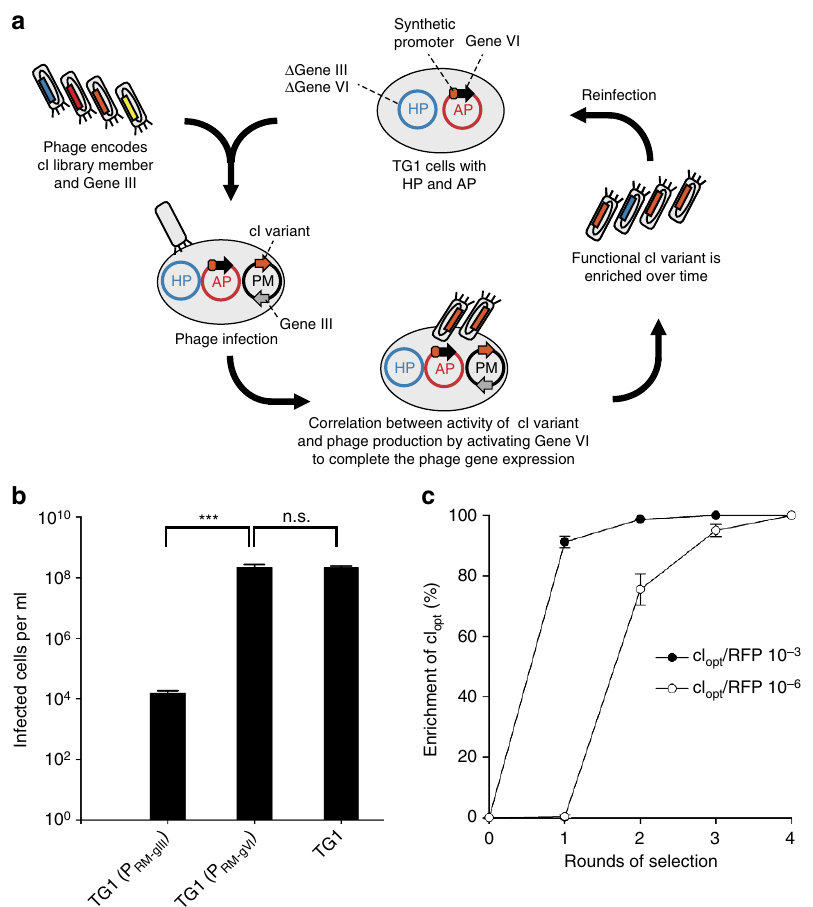
Figure 2 | Developing a phagemid-based system for the selection of combinatorial libraries. ( a ) Scheme of the phage-assisted selection system. E. coli cells containing the modified M13 helper phage (HP; contains all phage genes except genes III and VI) and an accessory plasmid (AP; containing a conditional gene VI expression circuit, dependent on variant cI activity) are infected with selection phages encoding a combinatorial cI library member on phagemids (PM; contain the variable cI genes and gene III). After infection, a protein with desired characteristics leads to an upregulated gene VI expression and therefore increased phage production. In this way, a protein with desired properties can be selected after several rounds of reinfection. ( b ) Testing for phage infection resistance from gene III or gene VI expression under the constitutive l P RM promoter. TG1 cells expressing no phage genes are used as a benchmark for maximum infection potential. A t -test was performed to test significance (*** ¼ P value o 0.001; n.s. ¼ not significant: P value 4 0.05). ( c ) Enrichment assays of l cI opt from mixed phage populations, diluted 1:10 3 or 1:10 6 with excess of RFP-expressing phagemid. Enrichment of cI opt was analysed by calculating the ratio of white (cI opt ) to red (RFP) colonies on agar plates. In all experiments, phage encoding cI opt were fully enriched after the selection process. Error bars are 1